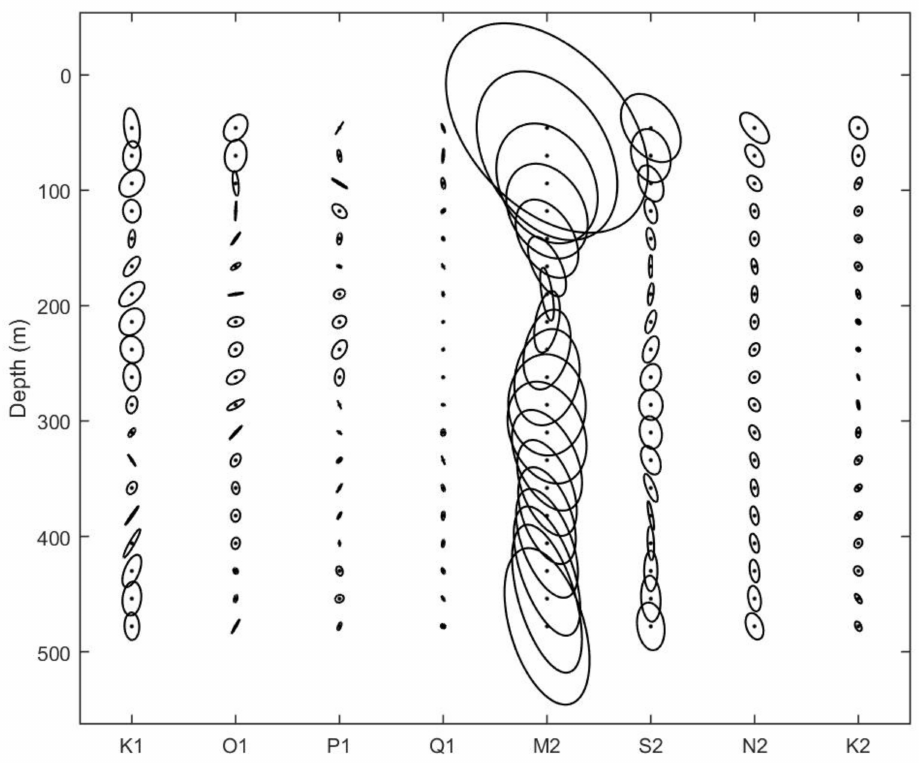
Figure 4. Tidal ellipses of eight baroclinic tidal constituents in different